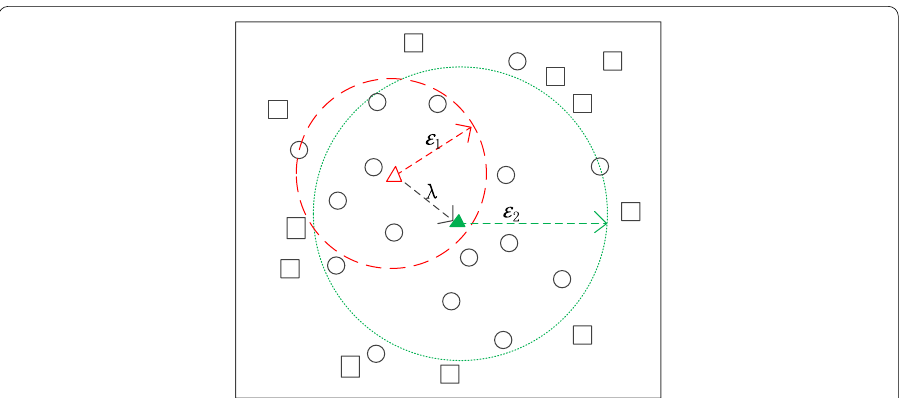
Fig. 1 Conceptual illustration of video hashing for authentication with maximized robustness. Red hollow triangle represents feature of original video. Small circles and rectangles represent features of similar and dissimilar video. The feature offset lambda can define a new boundary shown in green dotted circle, with new feature green triangle as its feature center and new radius epsilon 2 as its robustness. Compared with its former robustness epsilon 1, the robustness is maximized but without loss of